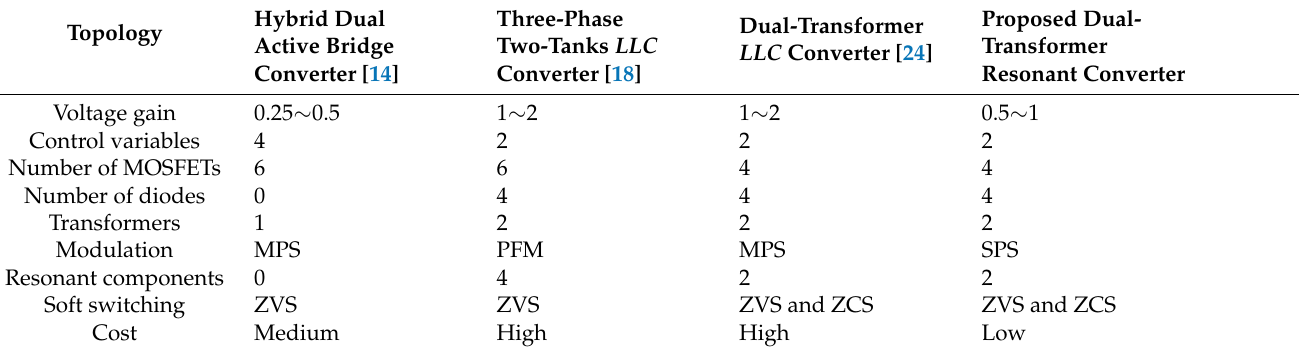
Table 3. Comparison with other